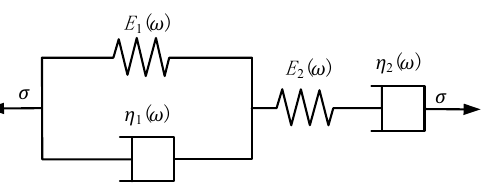
Figure 1. The creep constitutive model of coal-rock combination considering the influence of moisture content.